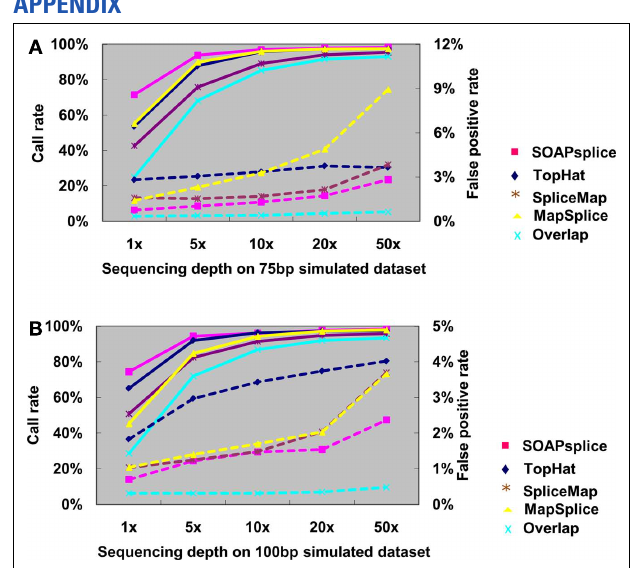
FIGUREA1 | Comparison of four tools for junction predictions using 75 and 100bp simulated reads. For 75bp reads in (A) and 100bp reads in (B) , the points joined by full lines stand for the call rate at different sequencing depth, and the points joined by dashed lines stand for the false positive rate. Call rate is equal to the number of true positives divided by the total number of junctions. False positive rate is calculated by dividing the number of false positives by the total number of detected junctions. Overlap represents the number of common junctions reported by all four